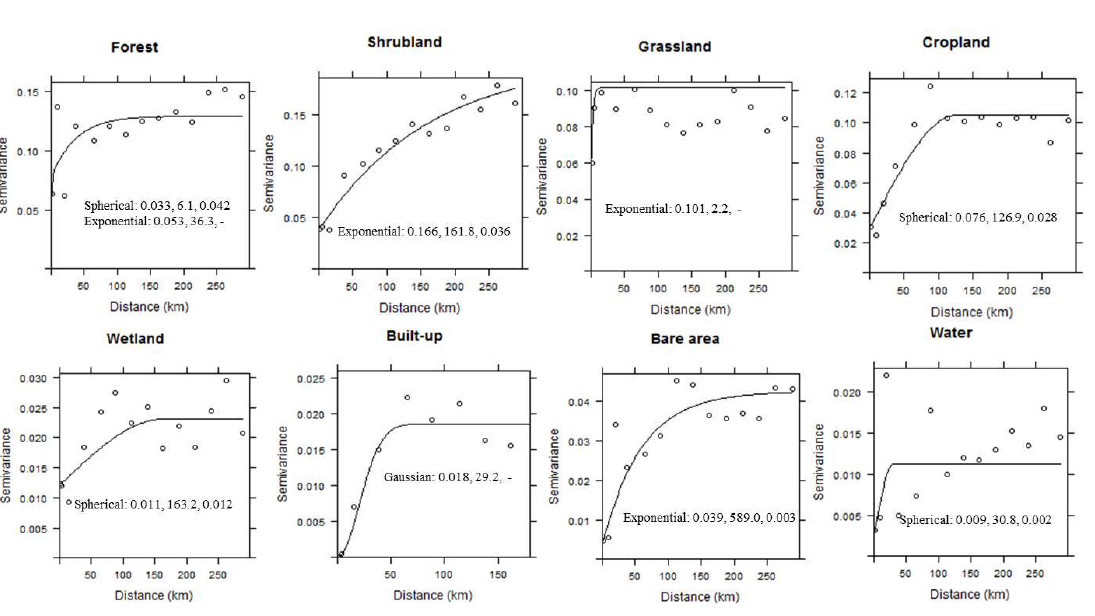
Figure 6. The semivariograms and fitted models used for Indicator Kriging.